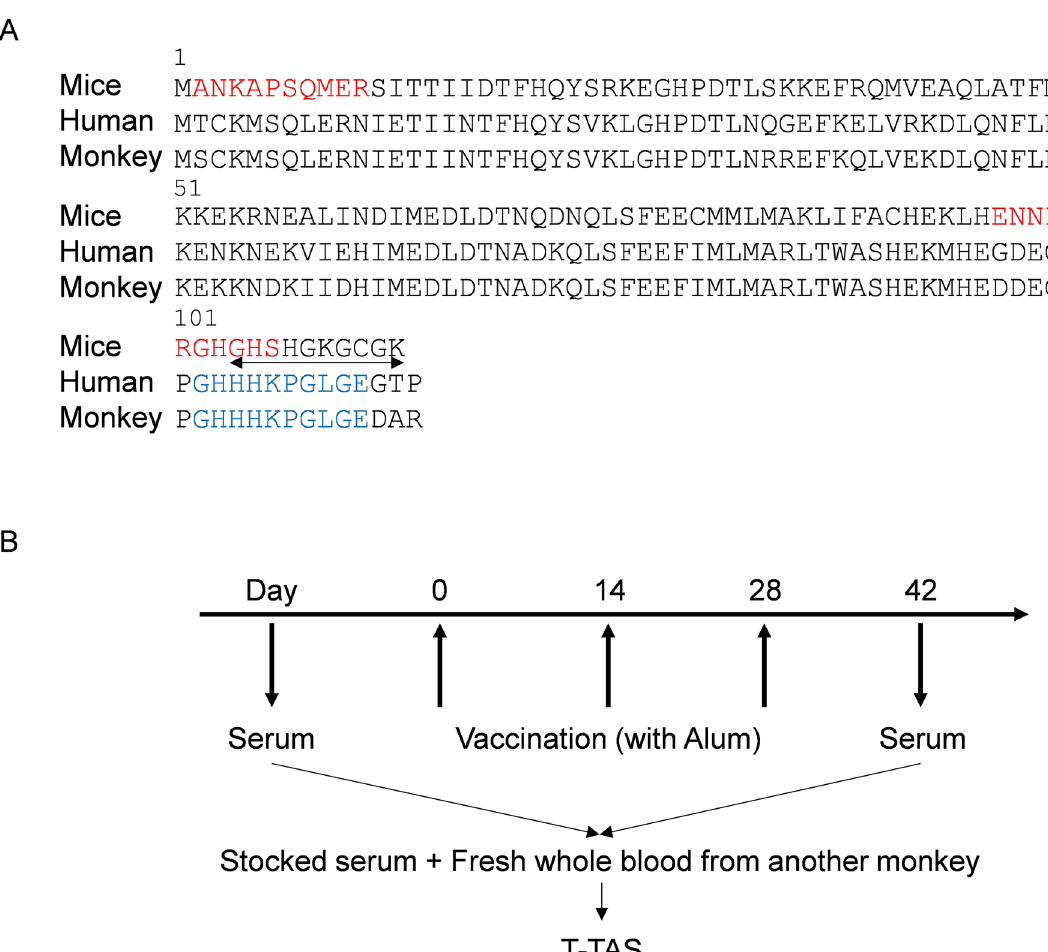
Figure 1. Selection of epitope and study protocol. ( A ) Selected epitope in S100A9 in mice, monkeys, and humans. For screening in mice, new epitopes (in red) and the previous epitope (double arrow) 6 were examined. The epitope colored blue was used in the monkey experiment. ( B ) Study protocol. Serum is collected before vaccination and 14 days after vaccination. Collected serum was added to the fresh whole blood from